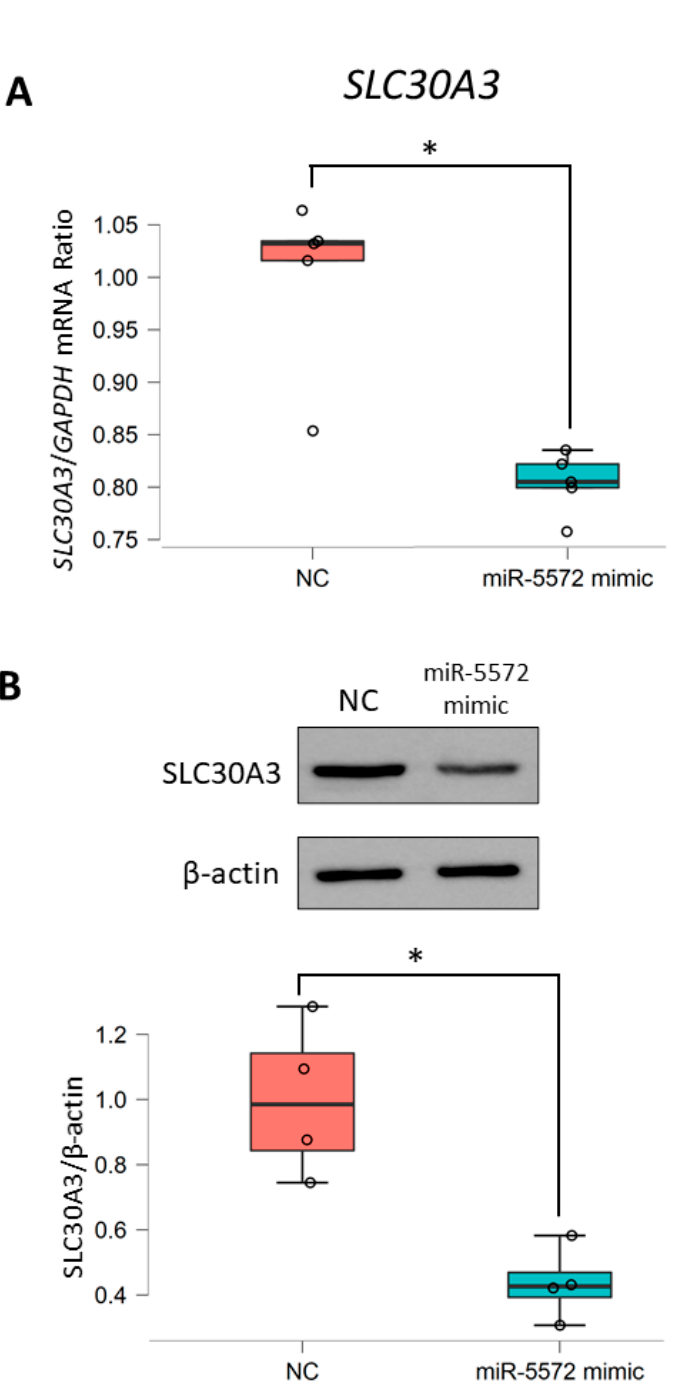
Figure 3. Determination of regulation of miR-5572 on SLC30A3 expression. ( A ) The level of SLC30A3 mRNA was determined in HEK293 cells transfected with negative control (NC) ( n = 5) and miR-5572 mimic ( n = 5) by real-time RT-PCR analysis. All data are presented as box and scatter plot. Statistical significance was determined by Student’s t -test (* p < 0.05). ( B ) The level of SLC30A3 protein was determined in HEK293 cells transfected with NC ( n = 4) or miR-5572 mimic ( n = 4) by Western blotting analysis. All data are presented as box and scatter plot. Statistical significance was determined by Student’s t -test (* p <